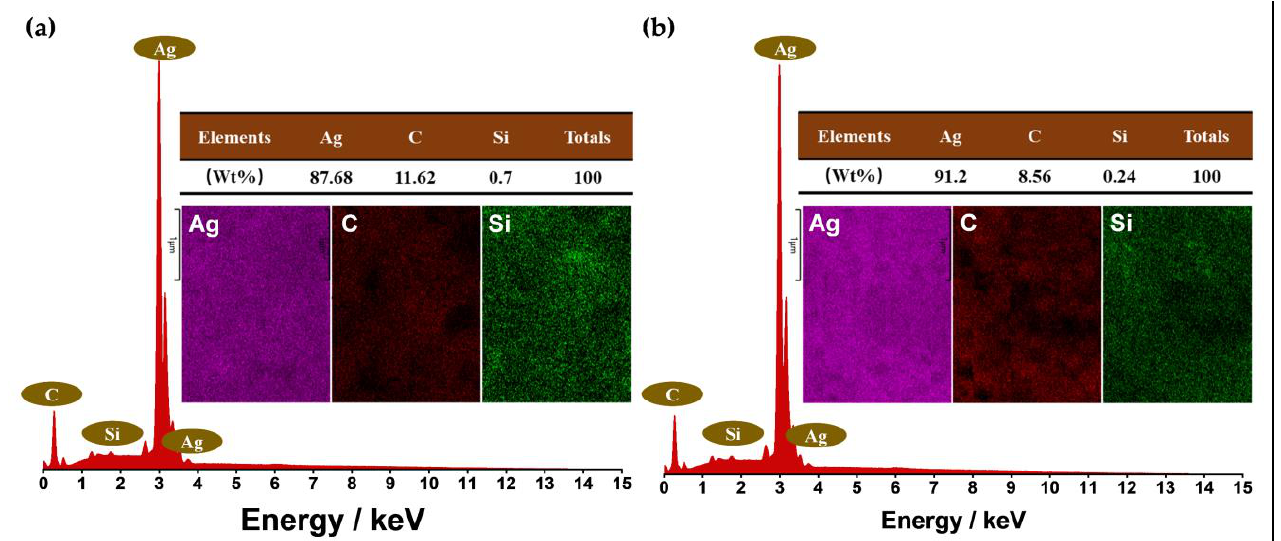
Figure 9. The EDS spectra of Ag conductive patterns. ( a ) 1030H-Ag-82% conductive ink; ( b ) 1030H- Ag-92% conductive ink.